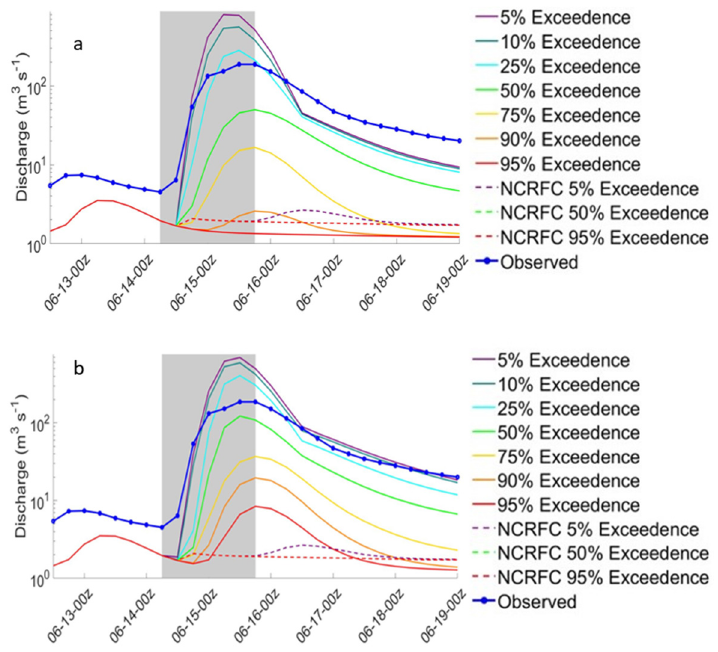
Figure 8. Same as in Figure 7, except for the Squaw Creek.